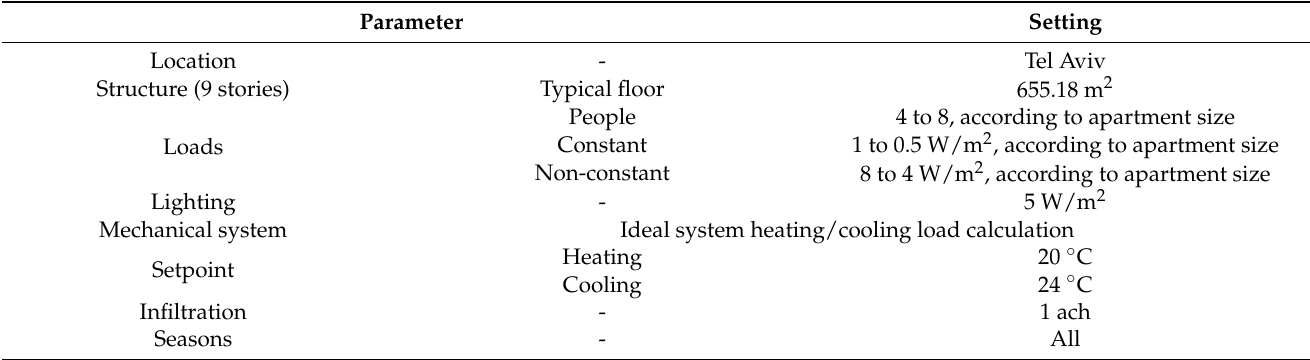
Table 2. Main settings of studied typical residential building.